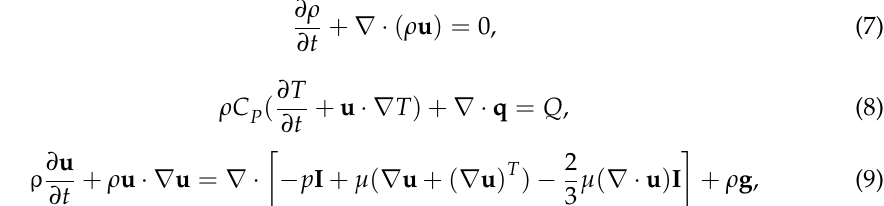
Figure 2. Thermal conductivity and specific heat capacity of the epoxy spacer at different tempera- tures .